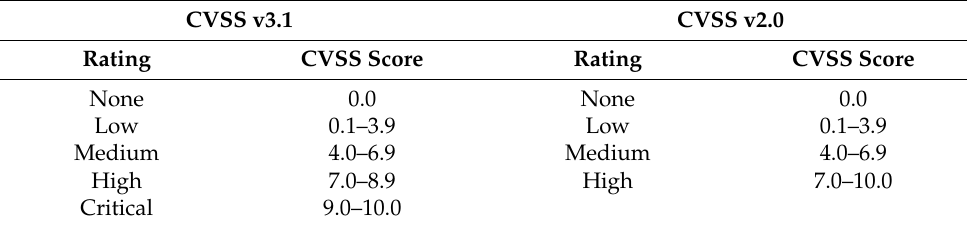
Table 1. Qualitative severity rating scale.